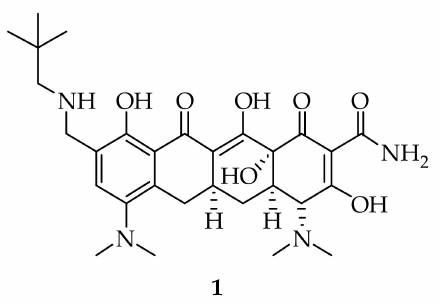
Figure 2. Structure of omadacycline ( 1